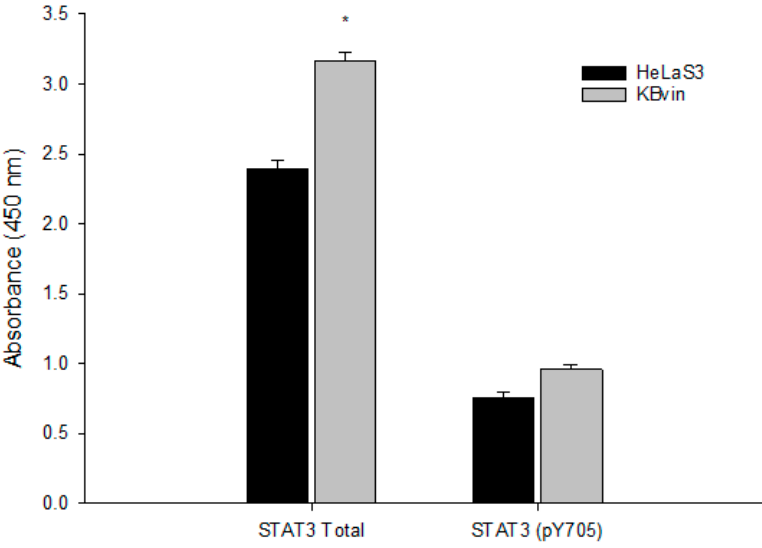
Figure 6. Structures of compounds 7 – 8 , 11 – 12 , and 25 – 26 .